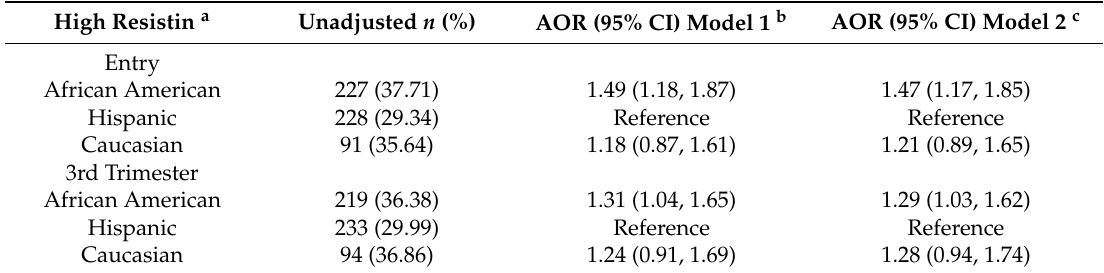
Table 4. Multiple logistic regression analysis for the associations of elevated resistin with